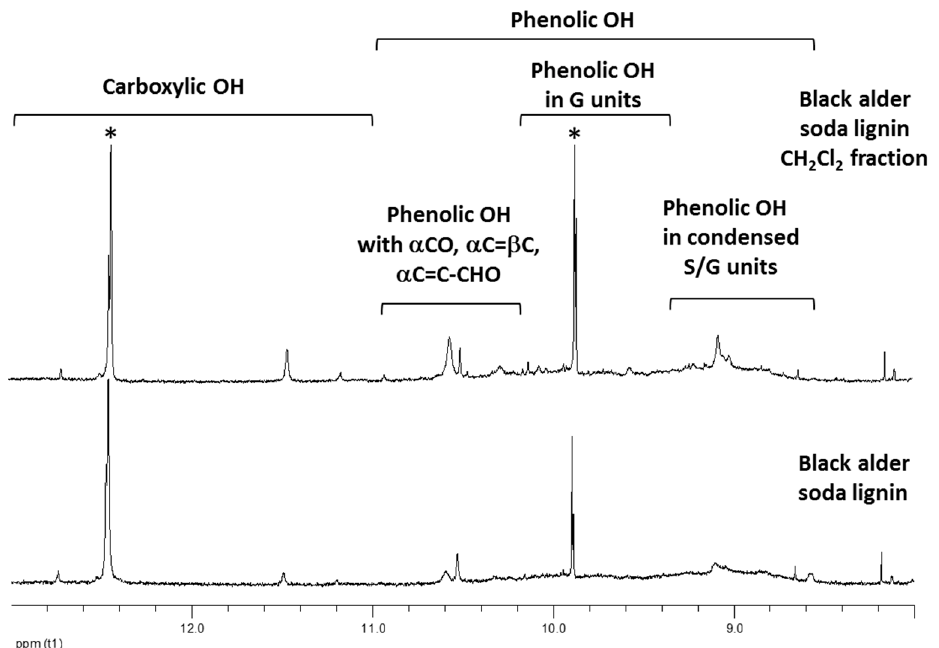
Figure 5. 1 H-NMR spectra (HMPT-d18, 298K) of parent black alder soda lignin and its fraction, extracted by CH 2 Cl 2 . Solvent contaminants peaks are marked by asterisk.